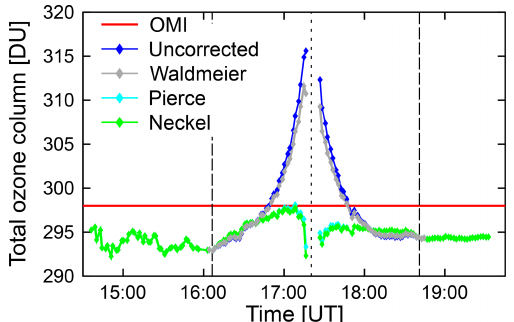
Figure 13. Total ozone column measured by GUVis-3511 and OMI. For “uncorrected” data, the spike in TOC during the period of the eclipse is an artifact that can be attributed to solar LD. The effect is only marginally reduced when using the LD correction based on the parameterization by Waldmeier. By using either the parameter- izations by Pierce or Neckel, variability in TOC during the eclipse is reduced to ± 2 . 6DU ( ± 0 . 9%).